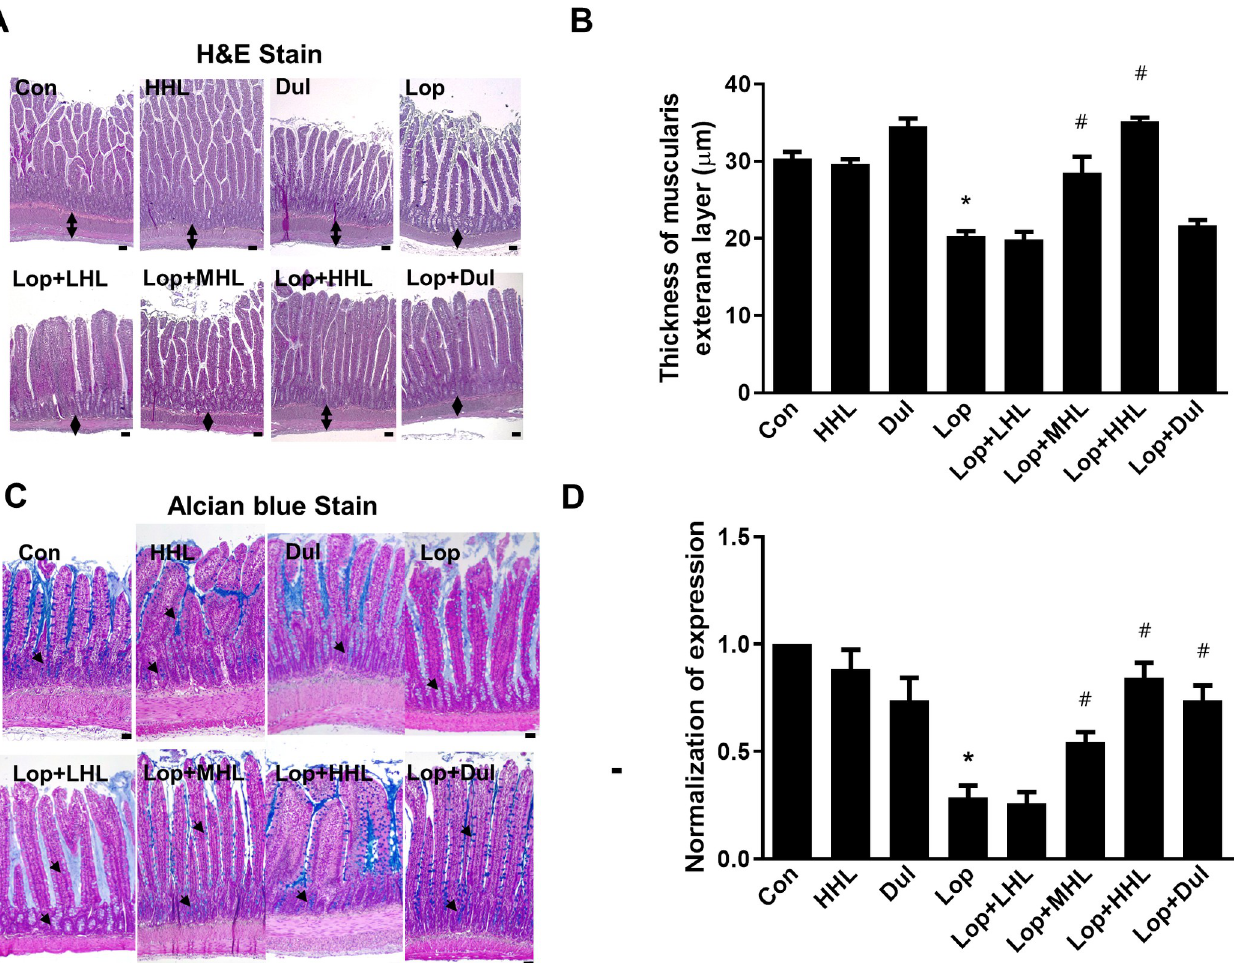
Fig 4. Effects of HLp-nF1 on the histological parameters in rats with loperamide-induced constipation. Eight-week-old rats were treated with loperamide along with 3.2 × 10 10 , 8 × 10 10 , and 1.6 × 10 11 cells/mL HLp-nF1, and Dulcolax individually. A single treatment with 1.6 × 10 11 cells/mL HLp-nF1 or Dulcolax was used as the control. ( A ) H&E-staining of the ilium and ( B ) the thickness of the muscularis externa layer was analyzed. ( C ) Alcian blue staining was performed as described in Materials and Methods, and ( D ) blue positive-mucin expression was quantified. A t-test was used to determine the means of two groups ( n = 3 ). � P < 0.05 vs. control group, # P < 0.05 vs. loperamide-treated group. Scale bar, 10 μ m. Con , control group; Lop , loperamide-treated group; Dul , Dulcolax-treated group (0.75 mg/kg); HHL , treatment with 1.6 × 10 11 cells/mL HLp-nF1; Lop+LHL , treatment with loperamide and 3.2 × 10 10 cells/mL HLp- nF1; Lop+MHL , treatment with loperamide and 8 × 10 10 cells/mL HLp-nF1; Lop+HHL , treatment with loperamide and 1.6 × 10 11 cells/mL HLp-nF1; Lop +Dul treated